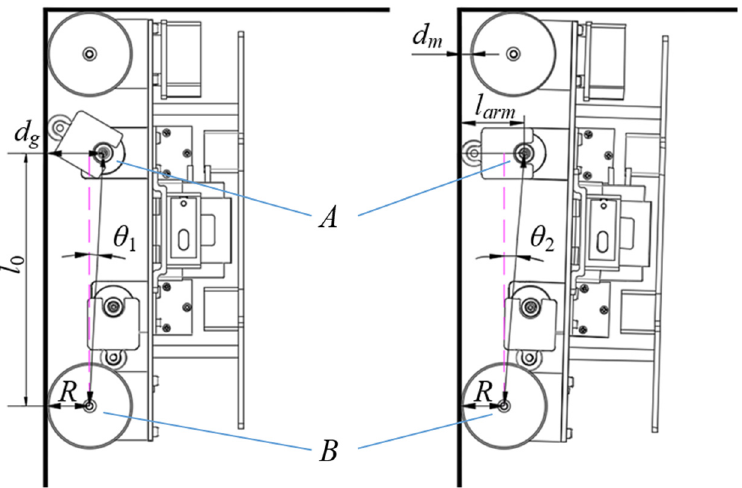
Figure 5. Schematic of the robot crossing a 90° concave corner.